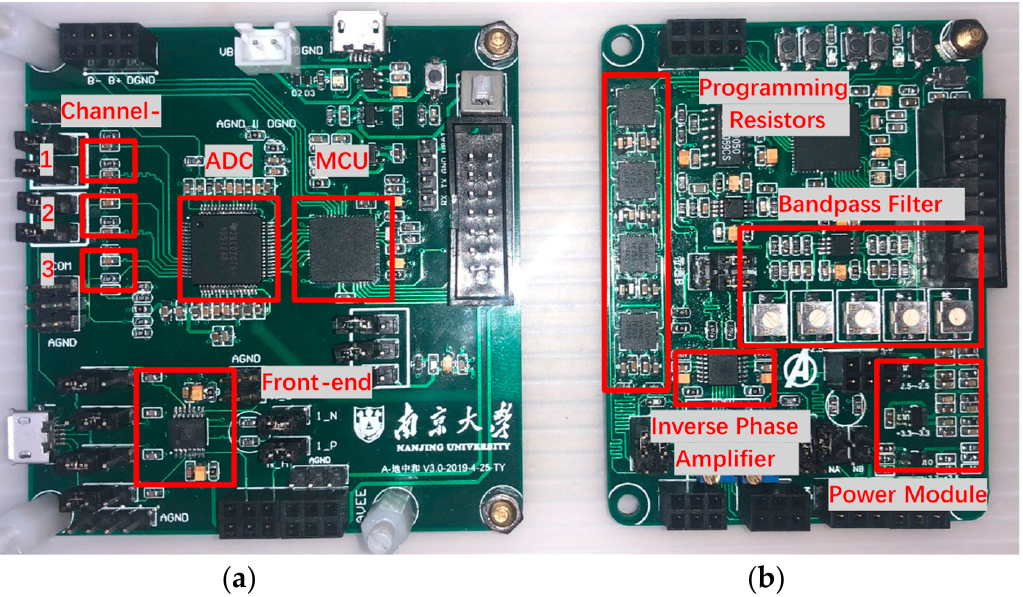
Figure 7. Circuit system for the proposed neutralization method, ( a ) the acquisition motherboard, ( b ) the noise neutralization board.